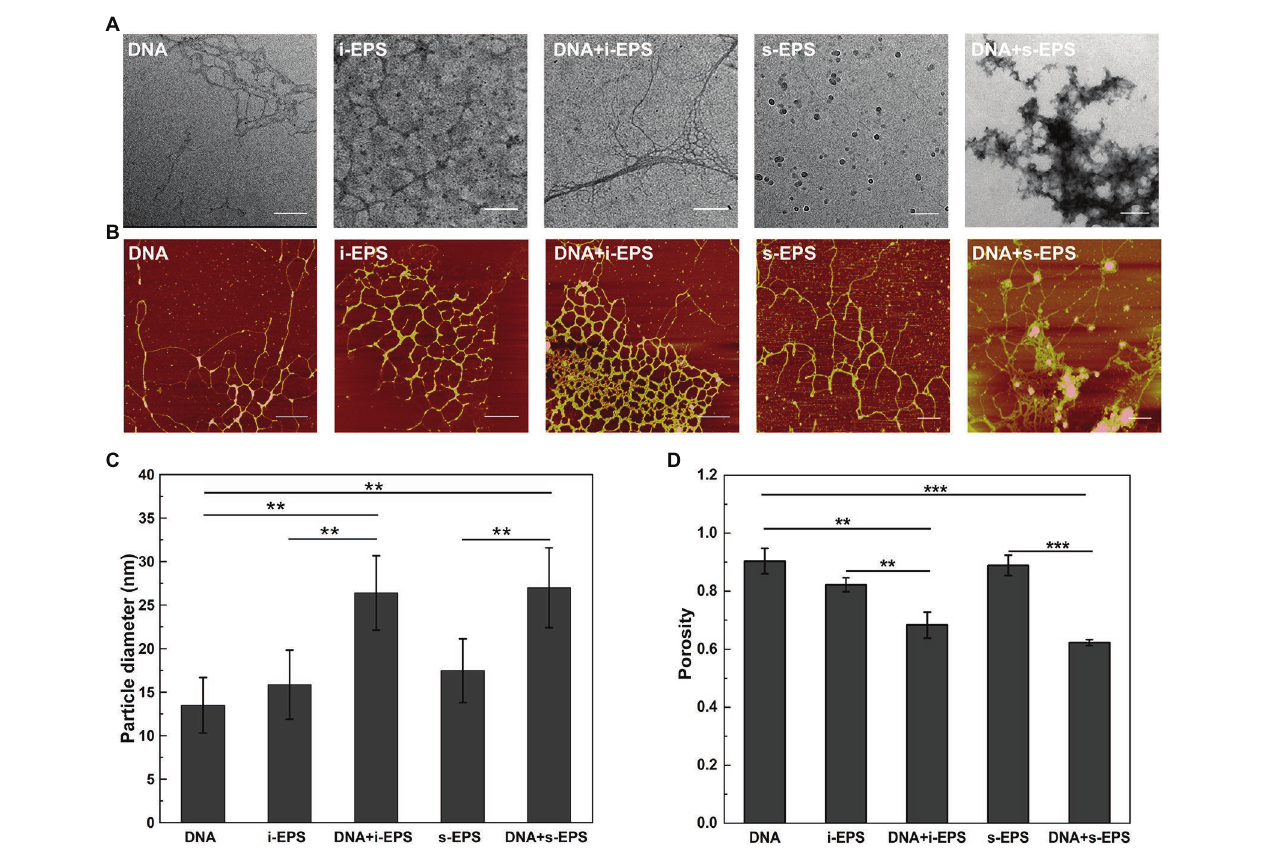
FIGURE 3 | Visualization of the DNA, exopolysaccharides (EPS), and DNA-EPS complex. Representative TEM (A) and atomic force microscopy (AFM; B ) observations of Myxococcus xanthus chromosomal DNA (DNA), insoluble EPS (i-EPS), DNA-insoluble EPS complex (DNA + i-EPS), soluble EPS (s-EPS), and